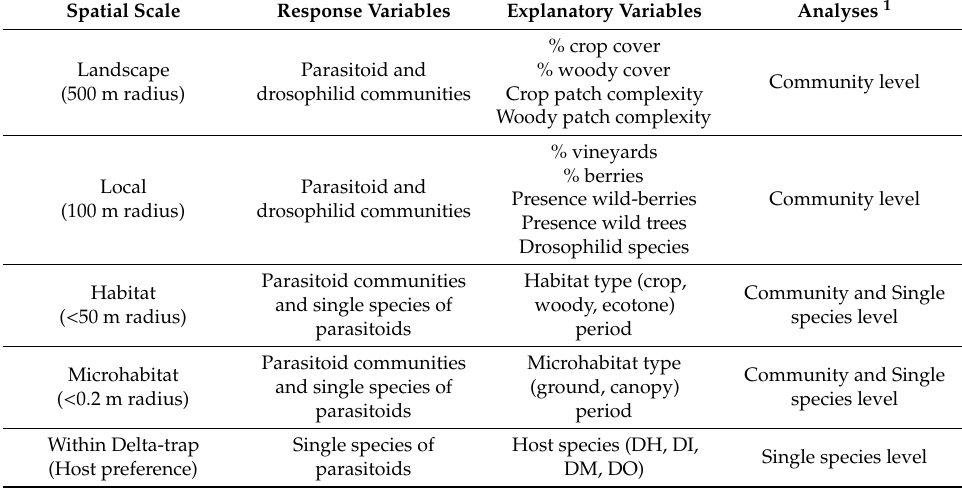
Table 2. Multiscale approach used to analyse the communities of parasitoids and their potential drosophilid hosts. DH: Drosophila hydei ; DI: D. immigrans ; DM: D. melanogaster ; DO: D. subobscura . For each spatial scale investigated, the list of the response and explanatory variables used in the analyses is